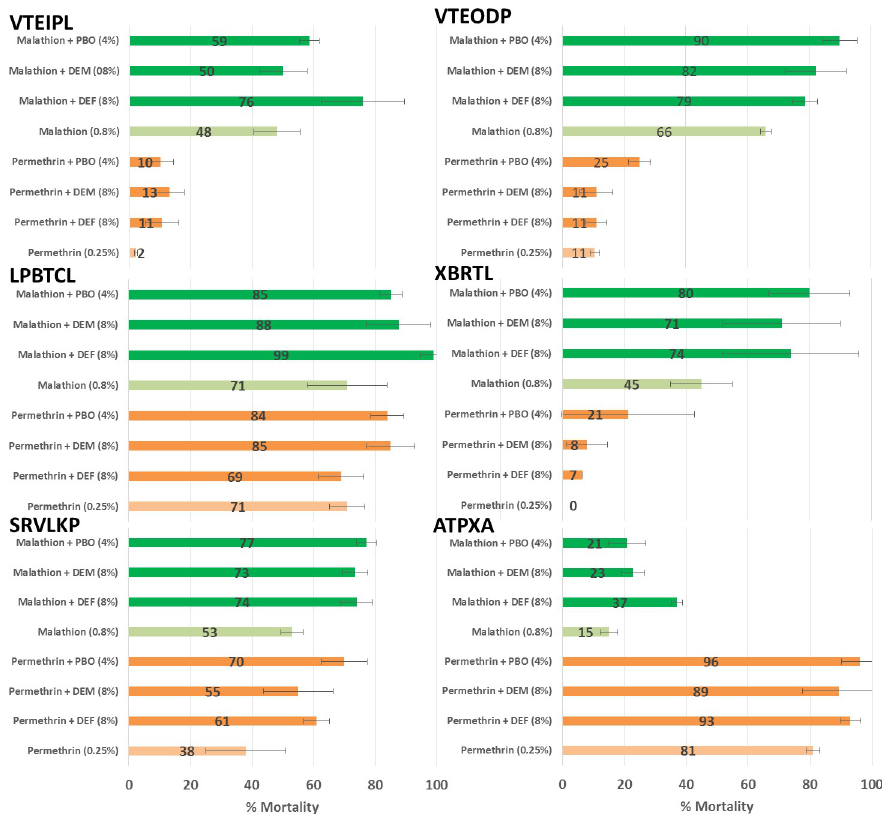
Fig 3. Mortality (%) and standard deviation of adult Aedes aegypti after exposure to permethrin (0.25%) and malathion (0.8%) with and without inhibitors (DEF: 8%, DEM: 8%, and PBO: